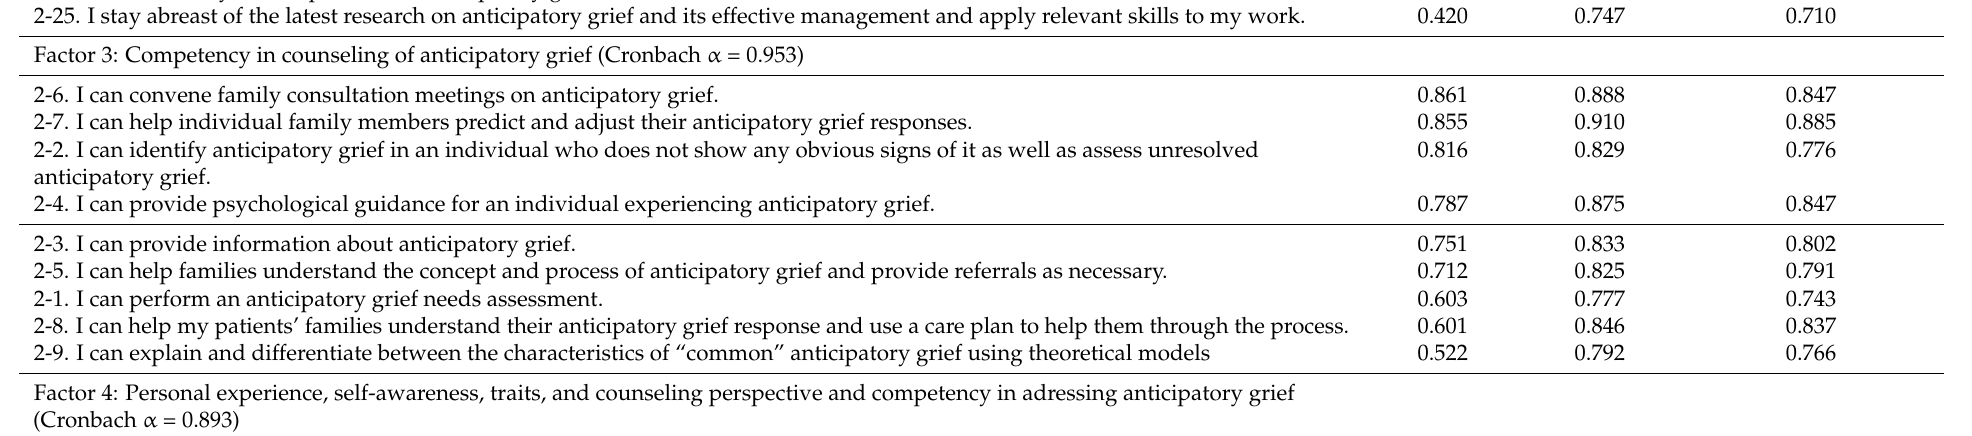
Corrected Item-Total